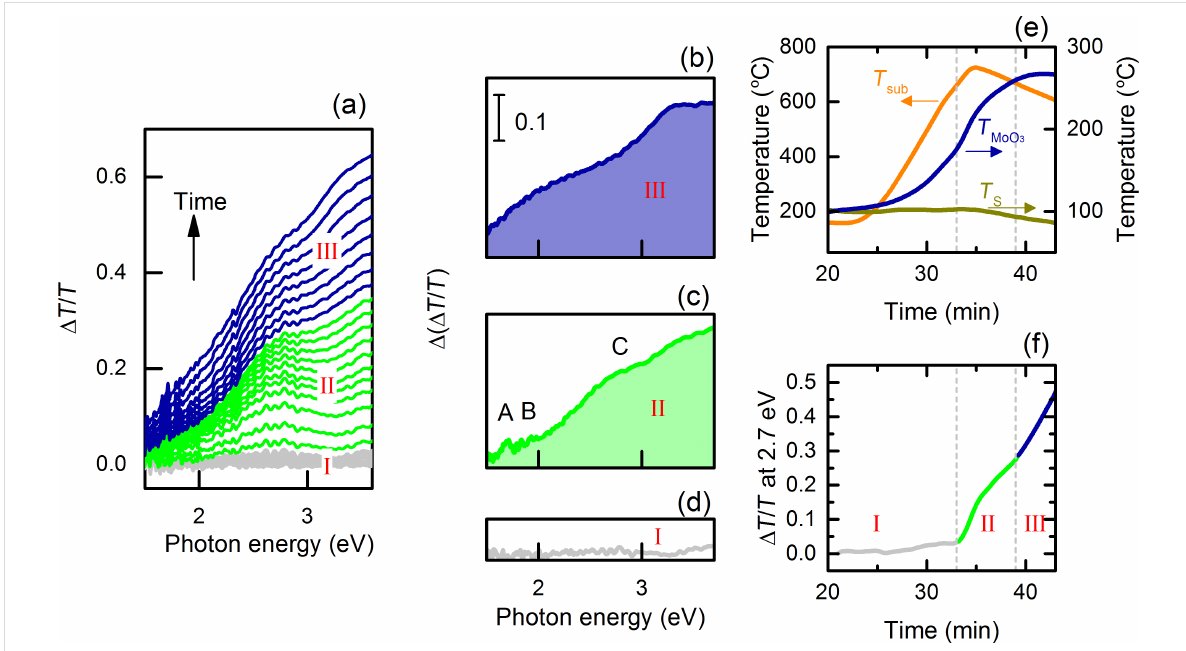
Figure 2: (a) Differential transmittance (DT) spectra ( Δ T / T ) recorded during CVD growth. The time interval between the adjacent spectra is 30 s. (b), (c) and (d) The incremental changes of the DT spectrum over the third, second and first sections of the growth, respectively. (e) The temperature profiles of the substrate ( T sub ), MoO 3 source ( ) and the sulfur source ( T S ) recorded during growth. (f) The corresponding DT intensity at 2.7 eV recorded during CVD